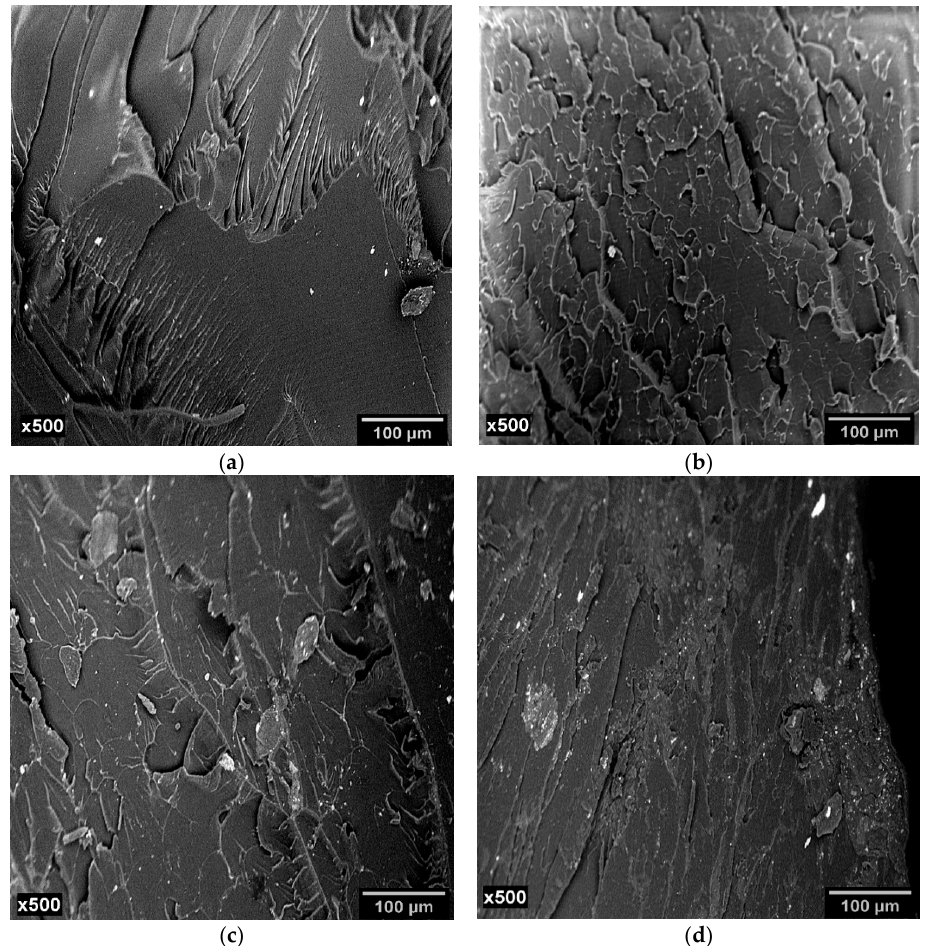
Figure 8. SEM images of fracture surfaces of ( a ) S 5 , ( b ) E 10 , ( c ) EM 10 , and ( d ) M 10 .